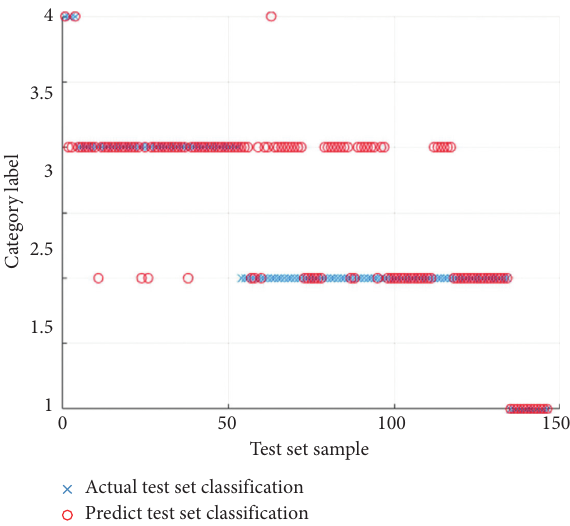
Figure 5: Results of corporate reputation risk classification. Table 3: Screenshot of loan interest and loan limit of some of the 302 companies. Enterprise code